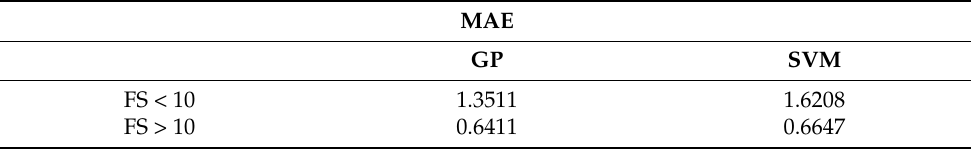
Table 11. Performances of SVM, GP, and ANFIS for FS < 10 MPa and FS > 10 Mpa.